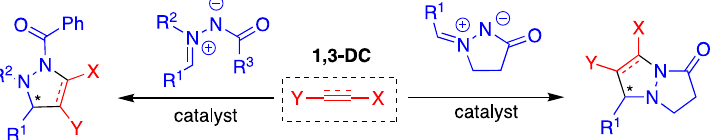
Figure 1. Construction of pyrazoline and pyrazolidine framework via 1,3-dipolar cycloadditions (DCs).